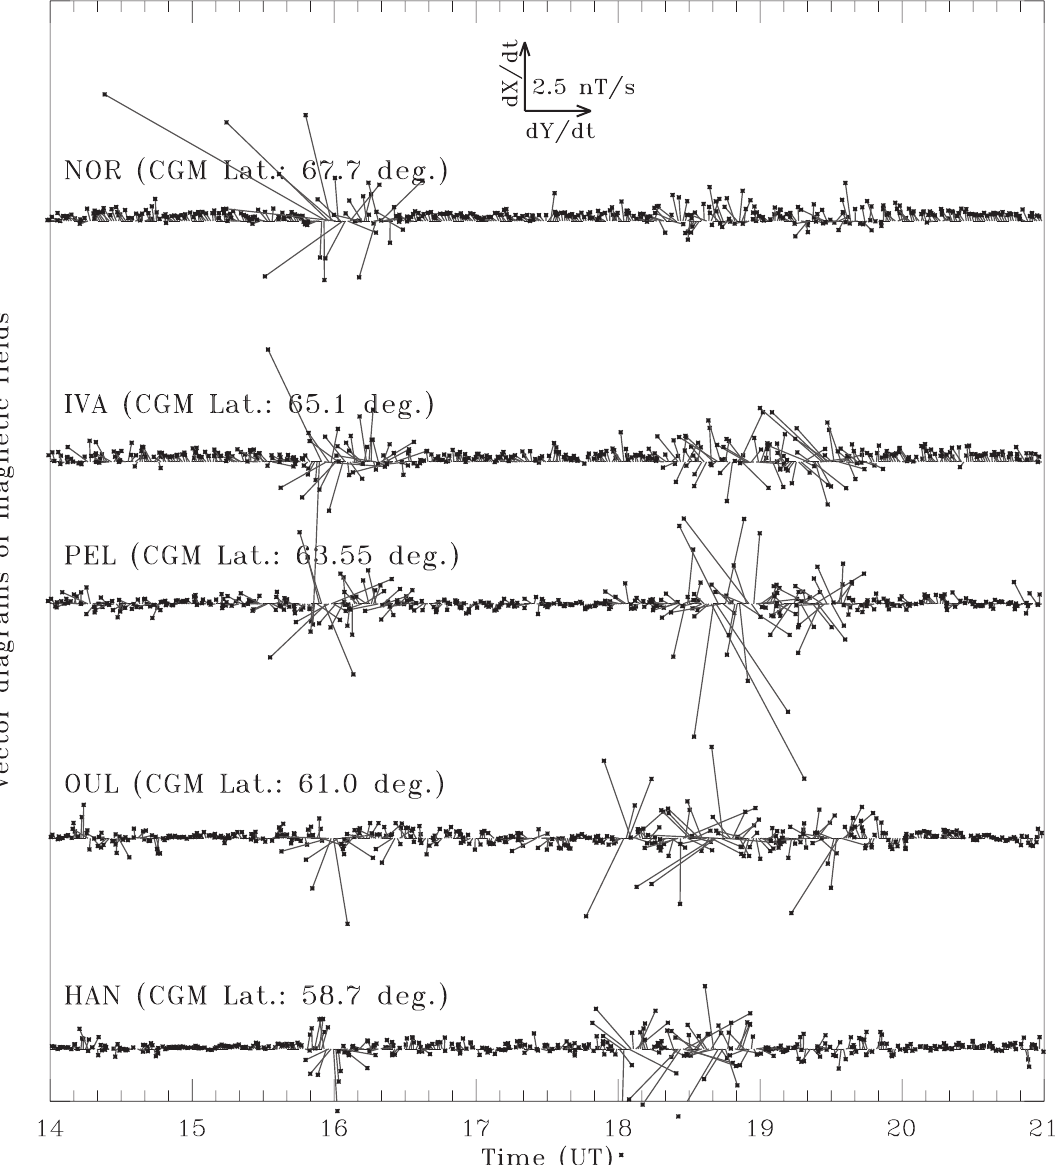
Fig. 10. Vector diagram of the d B /d t variations along the meridional pro fi le between 14 UT and 21 UT on 17 March 2013 (time step 1